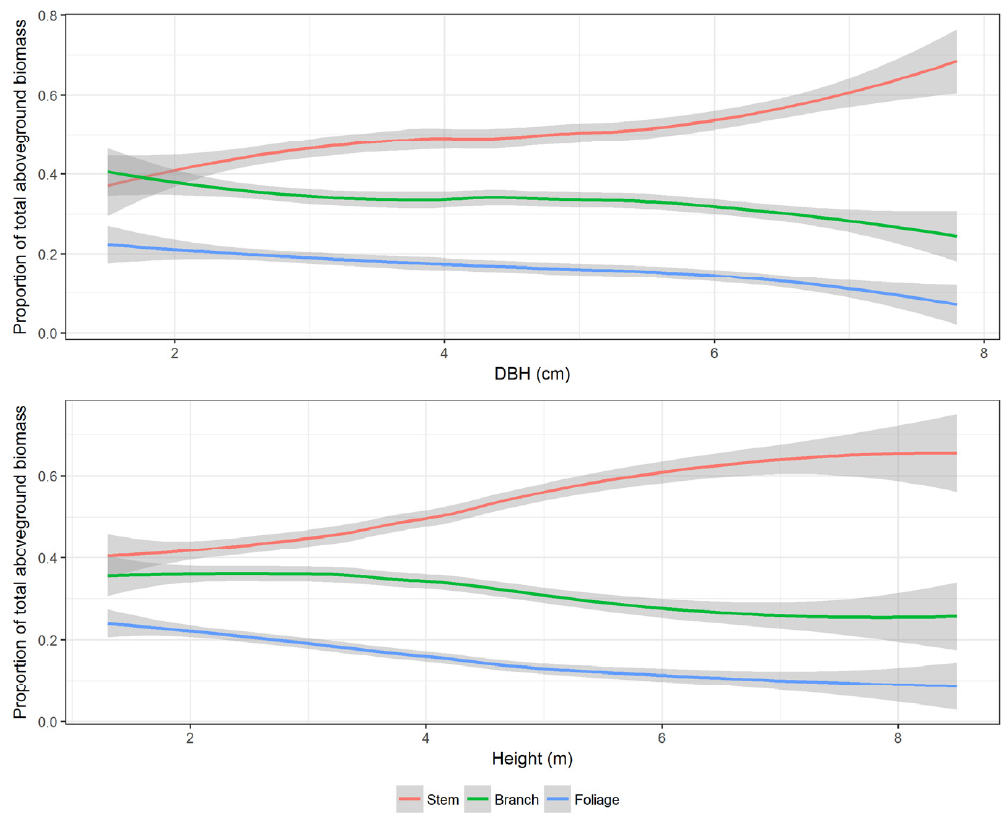
Figure 4. Trend in component biomass proportion with respect to DBH and total height. Trend lines are obtained through loess fit.